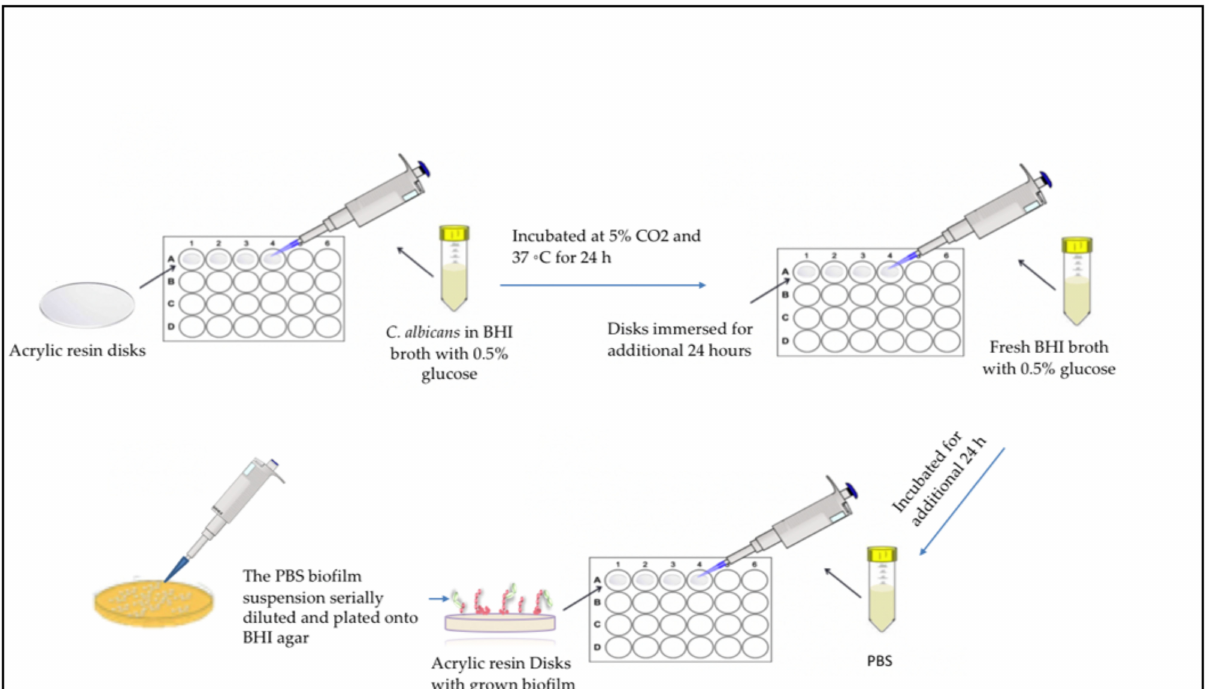
Figure 1. Biofilm growth on acrylic resin disks and antifungal colony-forming unit count